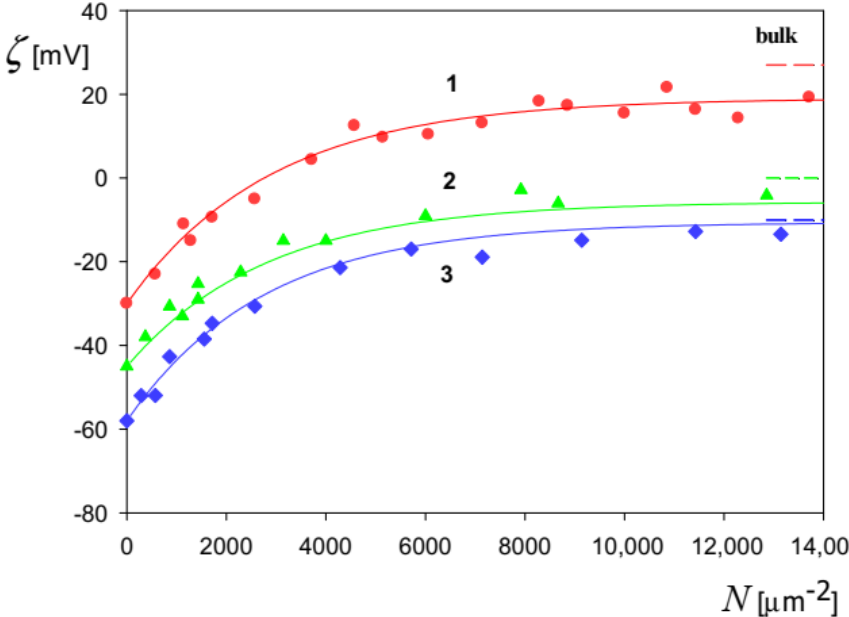
Figure 5. The dependence of the zeta potential of mica ζ on the surface concentration of HSA expressed in µ m − 2 . The points denote experimental results obtained from the streaming potential measurements for I = 0.15 M and various pH: (1) ( • ) pH 3.5; (2) ( (cid:78) ) pH 5.5; and, (3) ( (cid:7) ) pH